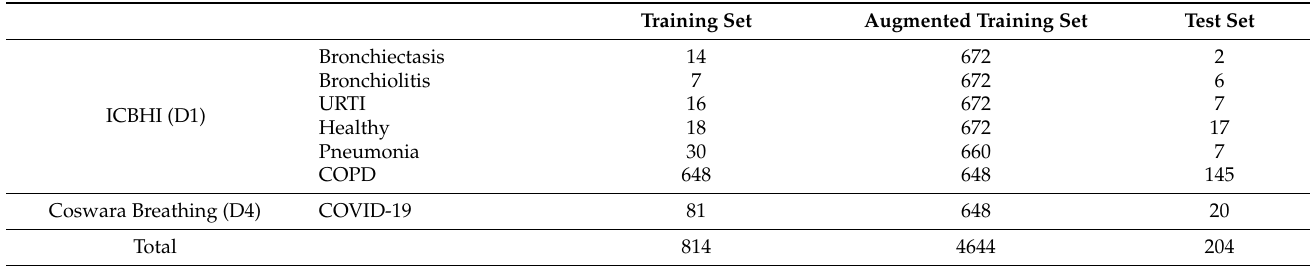
Table 4. The subject-independent train–test split for the combined dataset (D5) based on ICBHI and Coswara breathing